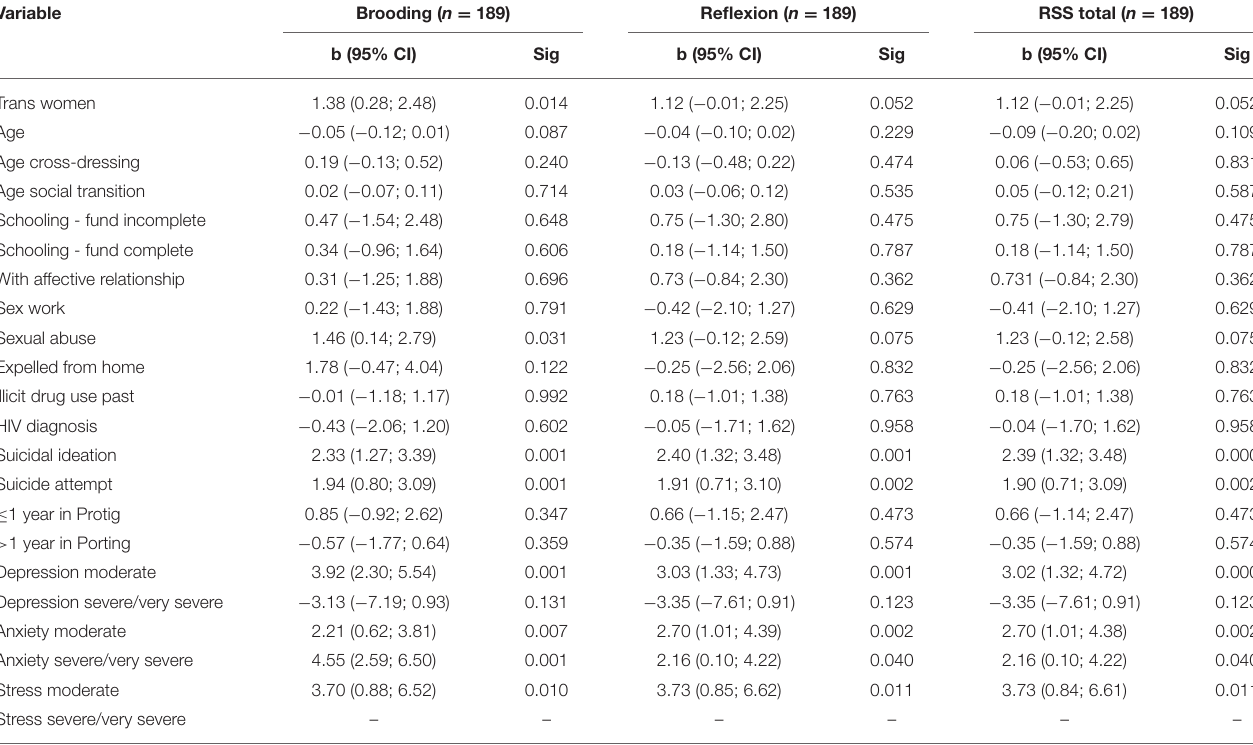
TABLE 2 | Bivariate model of brooding and reflexion associated with psychosocial, clinical and symptomatological variables ( n = 189).